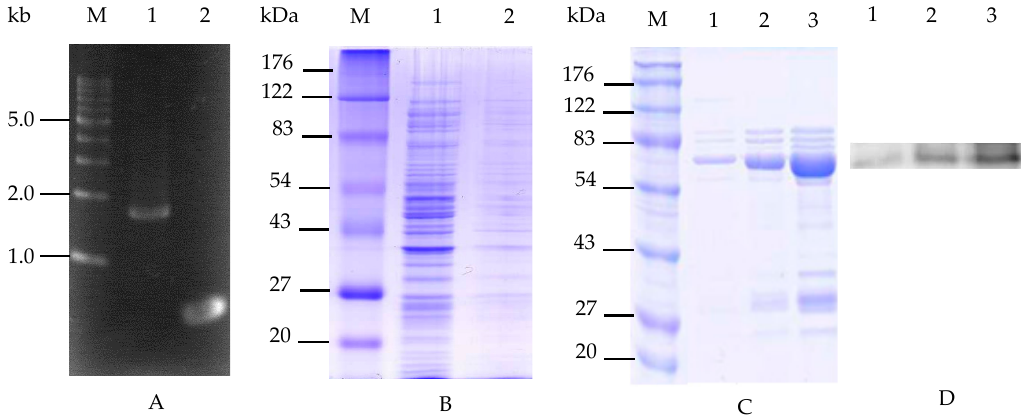
Figure 1. Targeted gene insertion and expression in E. coli . ( A ) The gel electrophoresis of amplified PCR cellulose products from B. licheniformis ATCC 14580 (lane 1) and INP from P. syringae KCTC 1832 (lane 2). M: 1 kb DNA marker; ( B ) SDS-PAGE analysis of the recombinant cells; M: standard protein